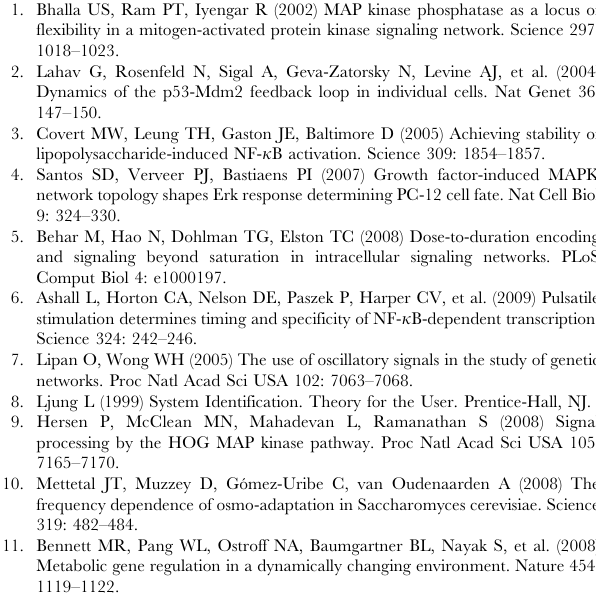
Figure S8 Band frequency filtering in the GalS/GalE system. GalE production rate and susceptibilities as a function of external cAMP concentration for [galactose] = 6 mM. The maximum in production (marked with a cross in Figure S8A) coincides with the change of sign of the output(GalE) susceptibility (red line in Figure S8B). GalS/GalE and CRP/GalE susceptibilities are shown with green and black dashed lines respectively in panel B. See Section 7 in Text S1 for model details. Found at: doi:10.1371/journal.pone.0012314.s009 (0.02 MB EPS) Figure S9 Band–pass frequency filtering of a quorum sensing network. A. The synthetic construction experimentally studied by Basu et al., Ref. [28] in main text, includes an incoherent FFL where the input AHL/LuxR activates both CI and LacI repressors, while CI also shuts off LacI expression. The output of the system is monitored by a LacI dependent GFP. B. GFP output measured as a function of external AHL. The inset shows a zoom of the GFP response around the peak, where the oscillatory high–pass filter and noise filtering regimes are indicated by arrows. C. LacI susceptibility as a function of AHL. Note that it changes sign around maximum GFP response. D. GFP oscillatory response(green line) for a periodic AHL input (blue line) with mean concentration 0.04 m M (orange circle in the inset of panel A). Model details are given in Section 7 of Text S1. Found at: doi:10.1371/journal.pone.0012314.s010 (0.12 MB EPS) Table S1 Definition of frequency detection parameters and corresponding susceptibility ranges for simple network